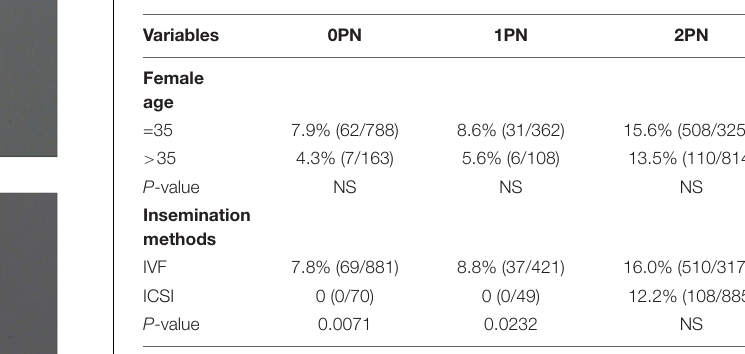
TABLE 3 | Prognostic factors associated with blastulation rate when Grade IV day 3 embryos.